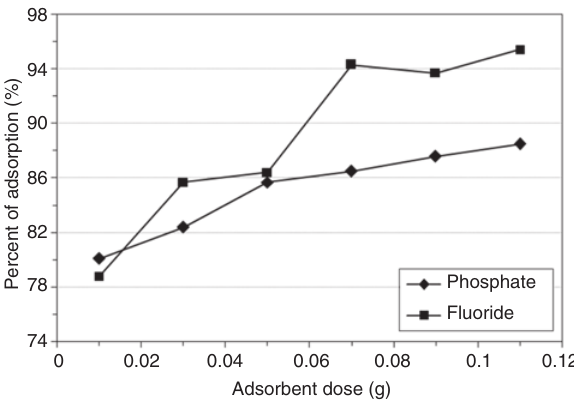
Figure 5: Effect of dosage to removal of fluoride and phosphate adsorption by MDL.